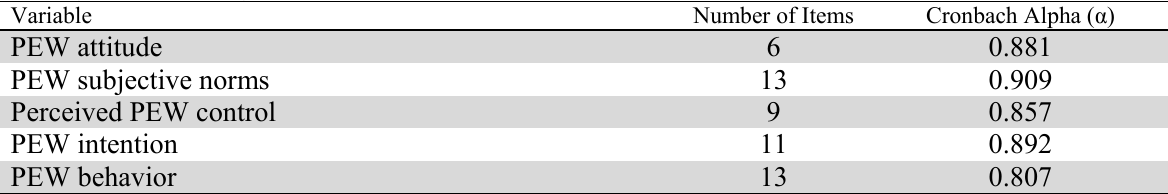
Validity and reliability for main variables Variable Number of Items PEW